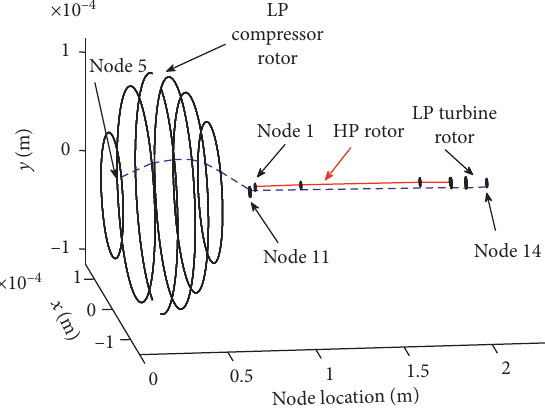
Figure 10: Orbits and modal shapes: ω